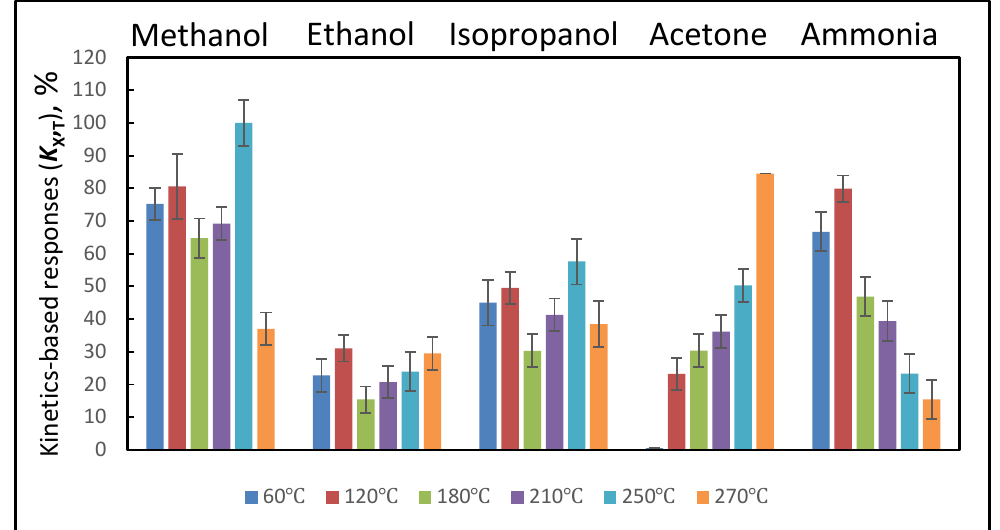
Figure 6. Normalized steady-state assessment based analytical signals ( R X , T ) of WO 3 / WO 3 − x -based sensing layer towards VOCs (methanol, ethanol, isopropanol, acetone) and ammonia gas at 60, 120, 180, 210, 250, and 270 ◦ C temperatures.